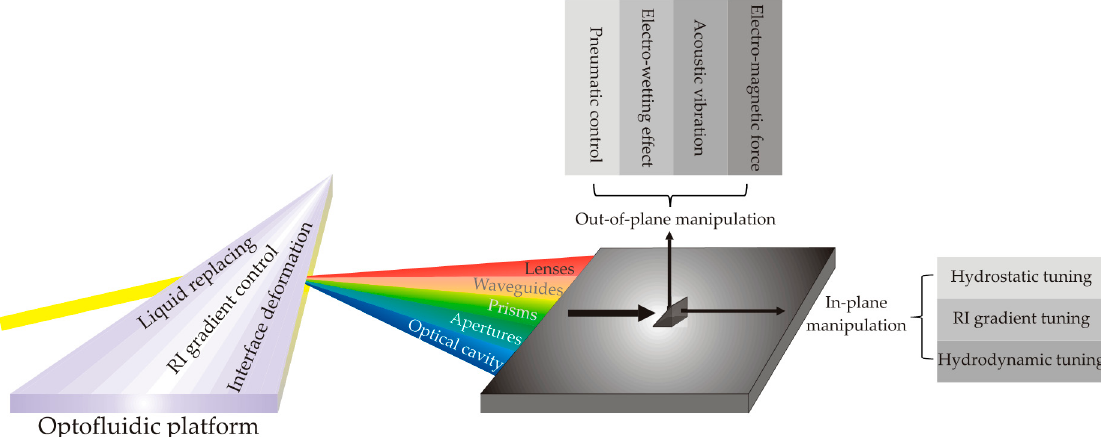
Figure 5. The categorization of optofluidic components in terms of their working mechanisms.